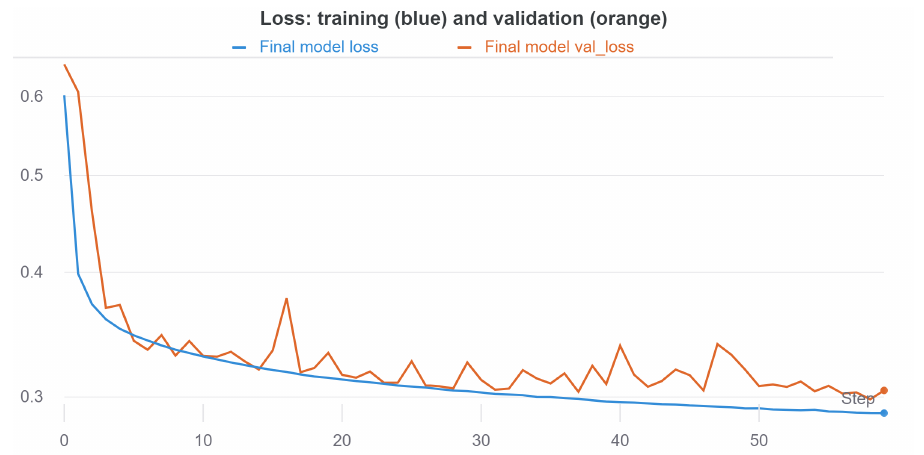
Figure 9. Plots of the loss during training (blue) and validation (orange) of the proposed model. After 50 epochs, the loss is reduced to 0.2749 and 0.2967 for training and validation, respectively.